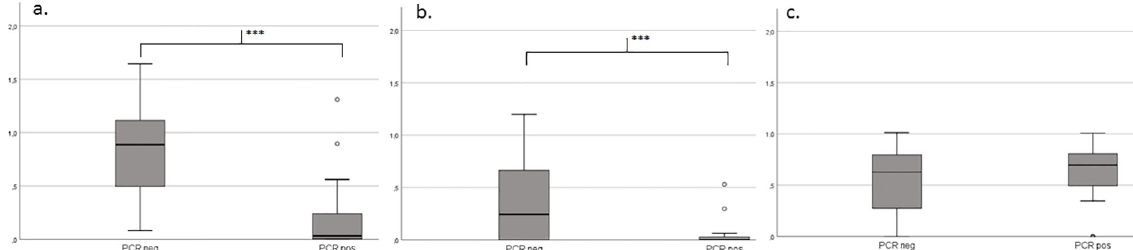
Fig 5. Shannon diversity scores for: (a) viruses, (b) eukaryotic viruses, (c) bacteriophages. COPD exacerbations of viral etiology had significant lower diversity (b). Boxes span IQR, ��� significant (a) all viruses (P < 0.001) and (b) eukaryotic viruses (p = 0.028), � outliers.